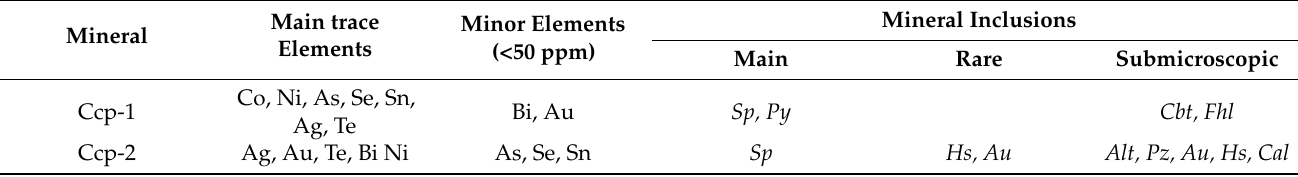
Table 11. Occurrence forms of main and trace elements and their mineral inclusions in chalcopyrite of different assemblages of the Petropavlovsk gold-porphyry deposit. Mineral